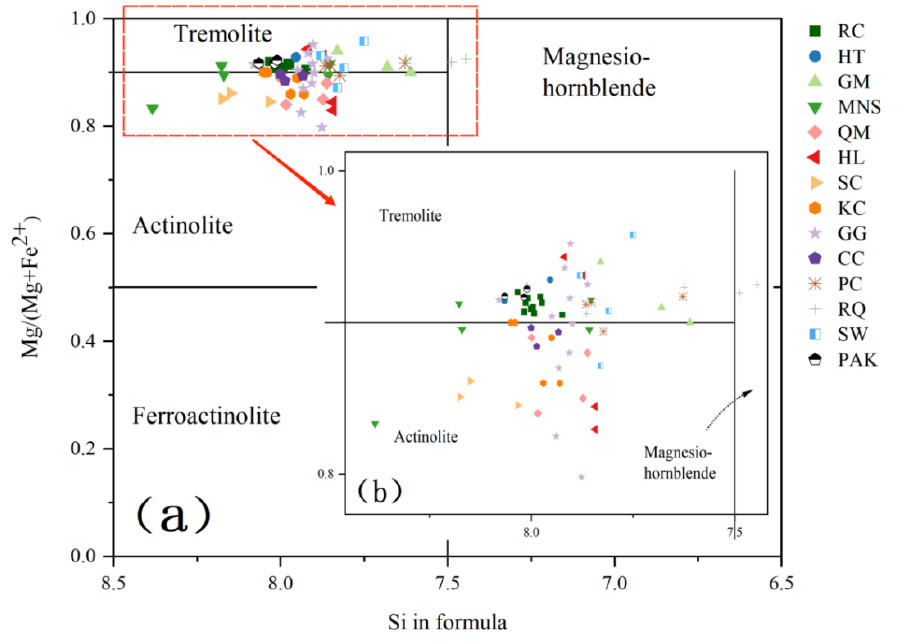
Figure 9. ( a ) Classification diagram of amphibole in nephrite (Adapted from Leake et al., 2004) [73]. ( b ) Zoomed-in version of Figure 9a.